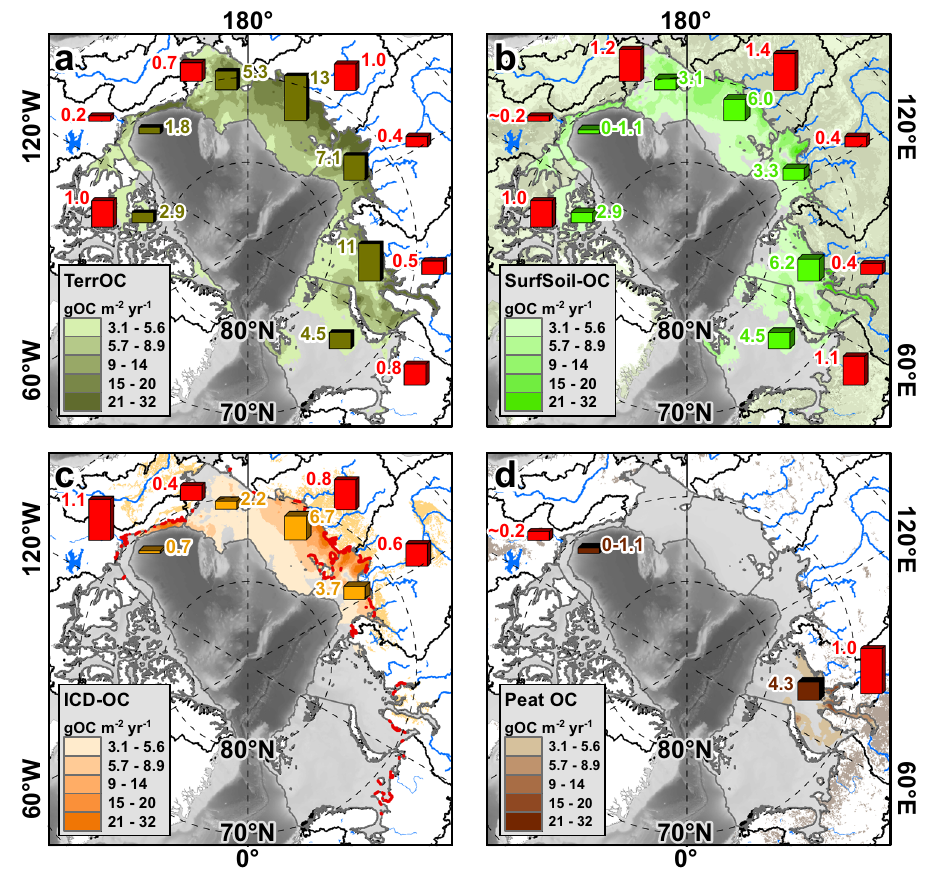
Fig. 3 | Circum-Arctic patterns of terrestrial organic carbon (terrOC) release. The four maps show accumulation rates of released terrOC apportioned between a total terrOC in dark green shades; b speci fi cally surface soil (SurfSoil) incl. per- mafrost active layer in light green shades; c Ice Complex Deposits (ICD) in orange shades 3 incl. costal erosion with >1myr − 1 outlinedin red 34 ; and d PeatOC in brown